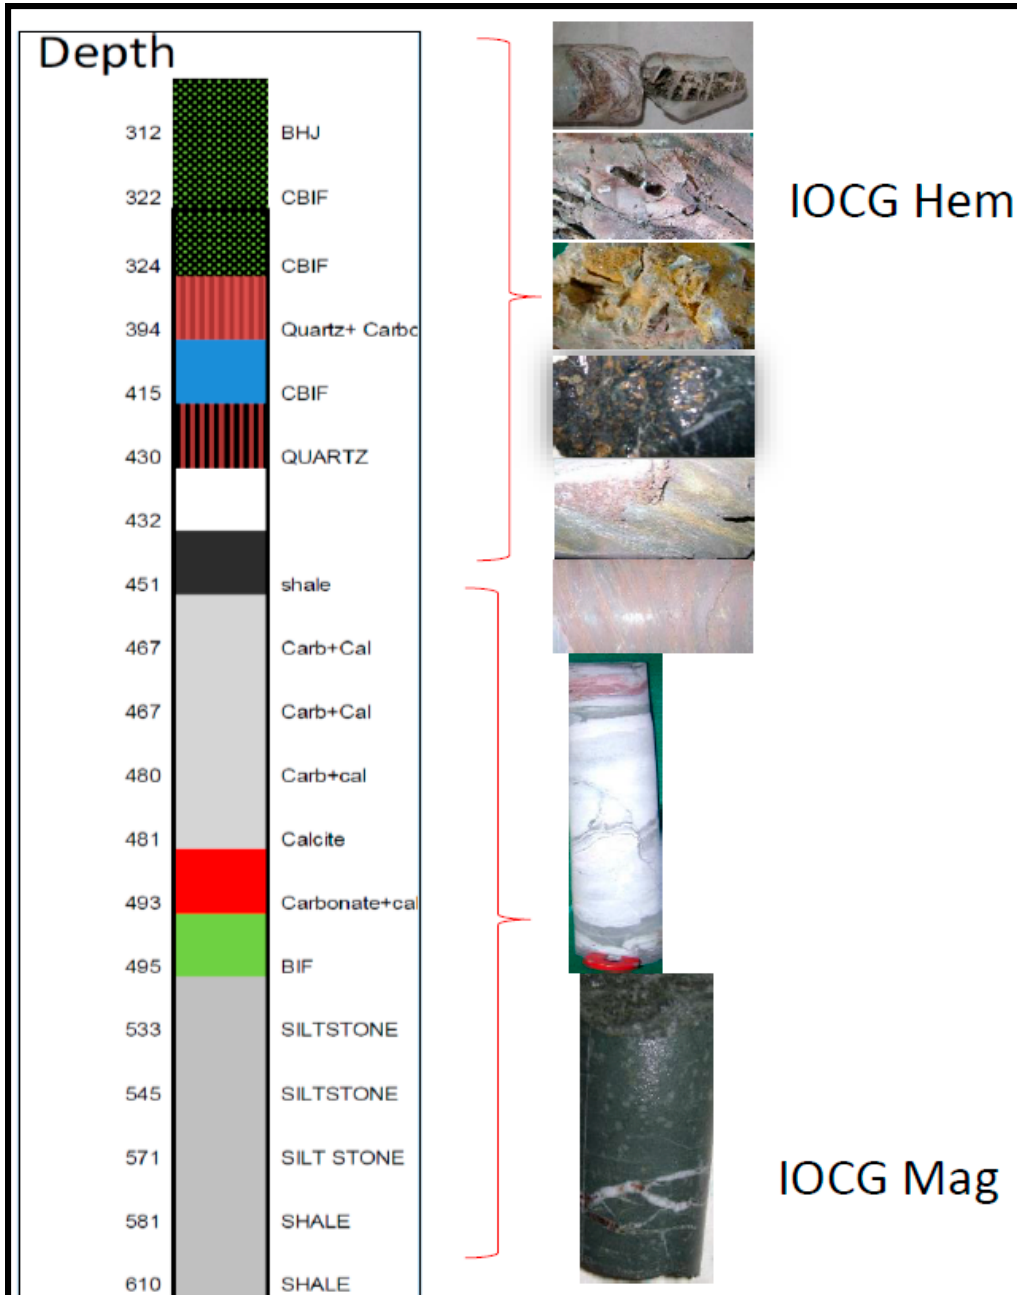
Figure 4. Core Log, Lithounits and core section of borehole DDH-1. Table 2. Core section lithology of DDH-1.